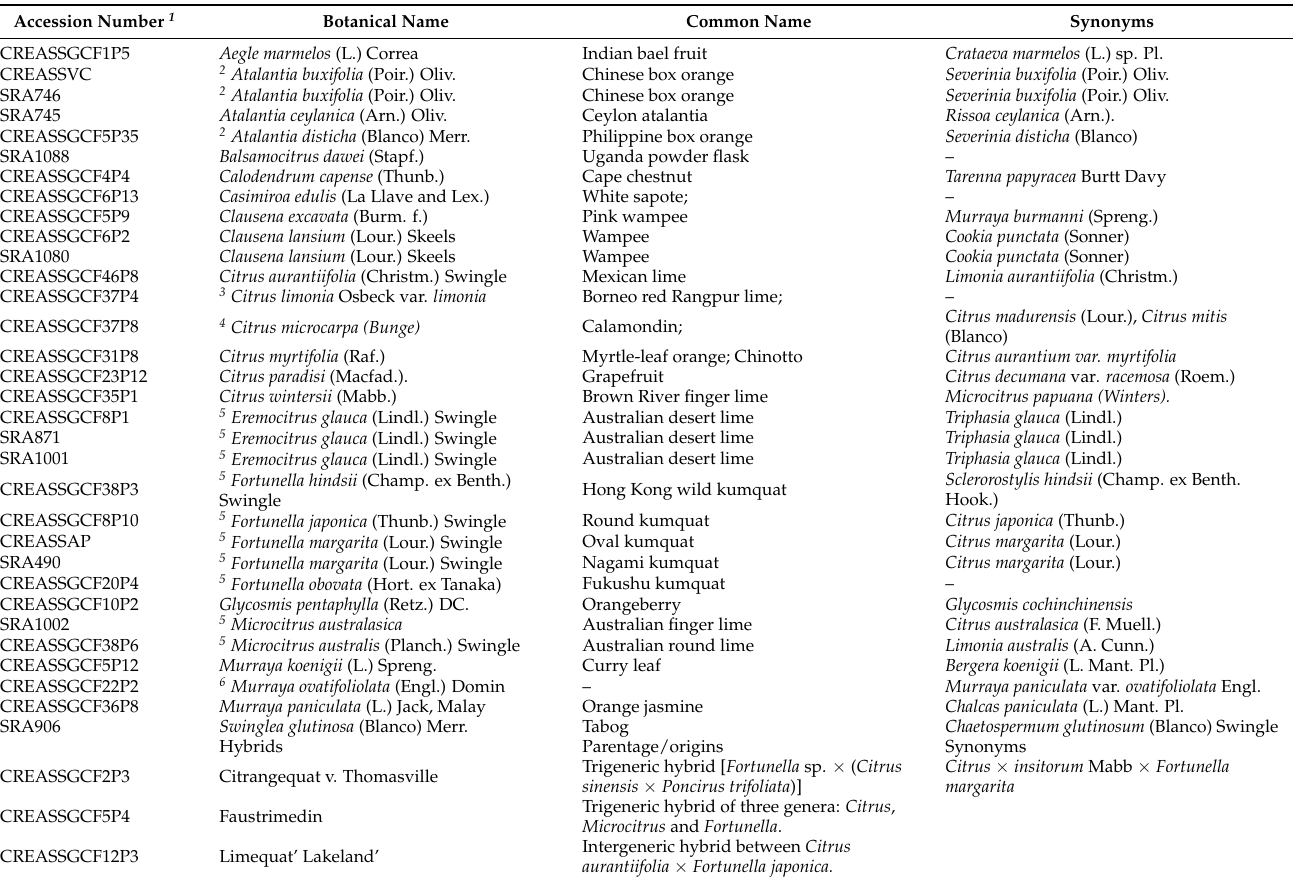
Table 2. Ornamental rutaceous plant accessions used for characterization of the host range and their reaction to the Xanthomonas citri pv. citri (pathotype A, A*, and A W ) and Xanthomonas citri pv . aurantifolii (pathotypes B and